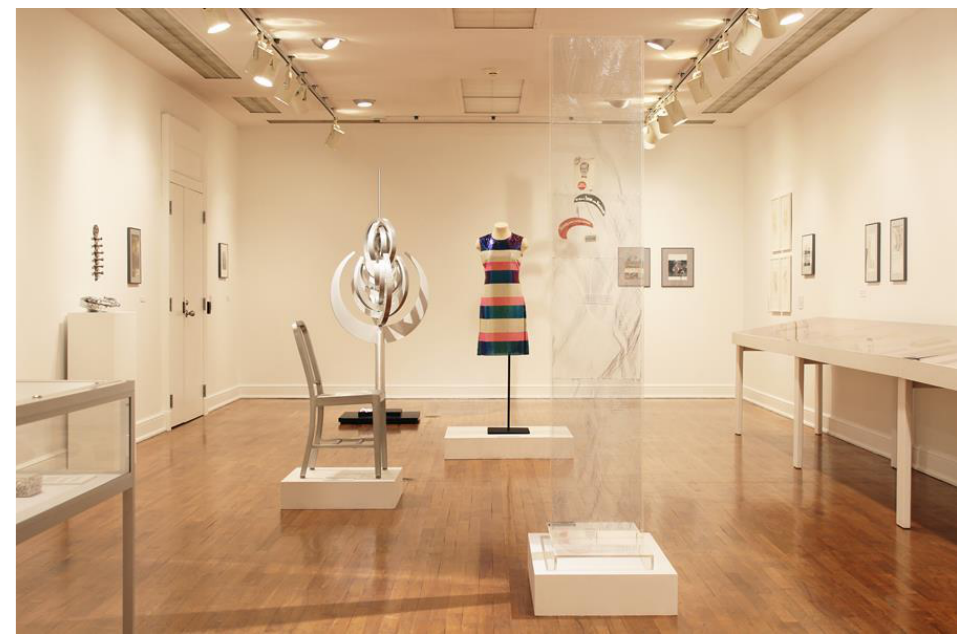
Metal from Clay, installation shot, November 2019. (Photo: Ana Rodríquez